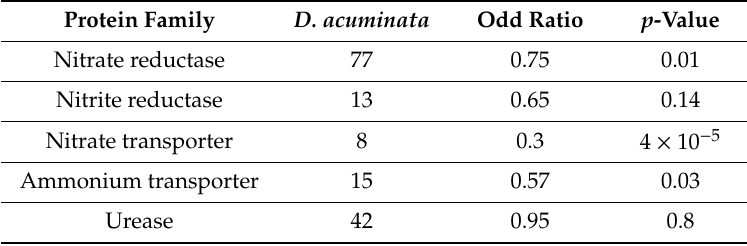
Table 3. Number of nitrate and nitrite reductase, nitrate and ammonium transporter, and urease homologs in the D. acuminata reference transcriptome. See methods for statistical analysis against a dataset of 32 dinoflagellates ( p <